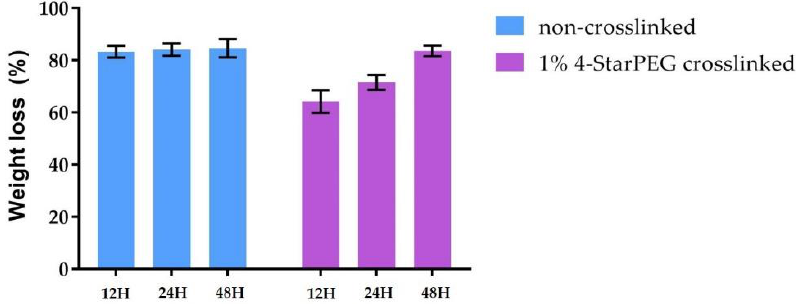
Figure 5. Weight loss of 4-StarPEG crosslinked and non-crosslinked Coll / MBG_Sr4% samples following incubation in collagenase up to 48 h.